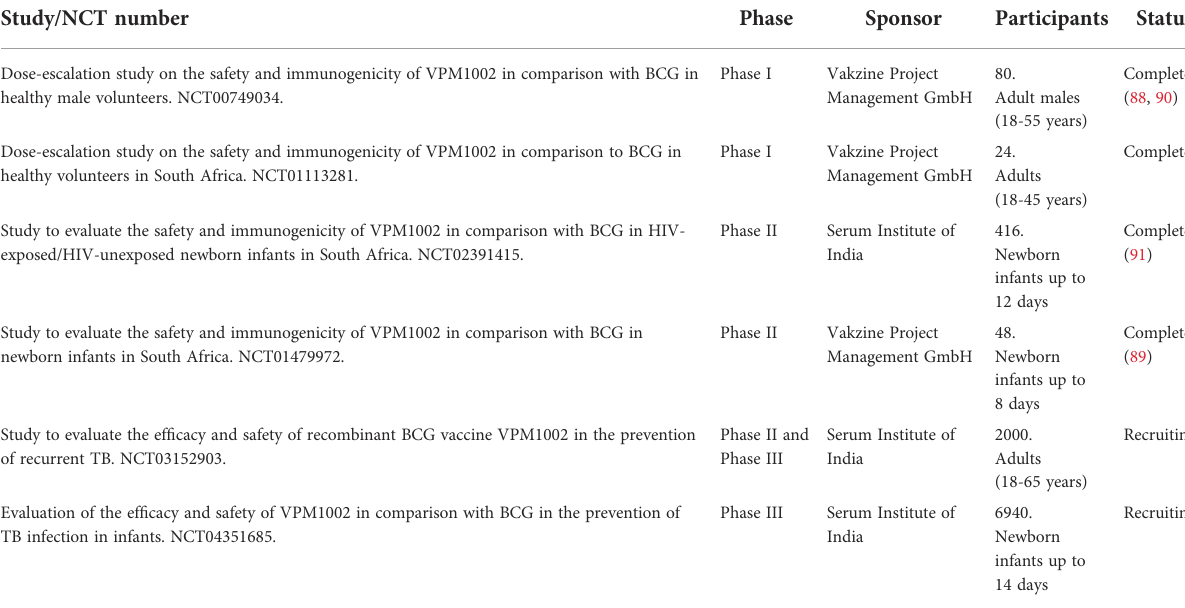
TABLE 1 VPM1002 clinical trials in the fi ght against